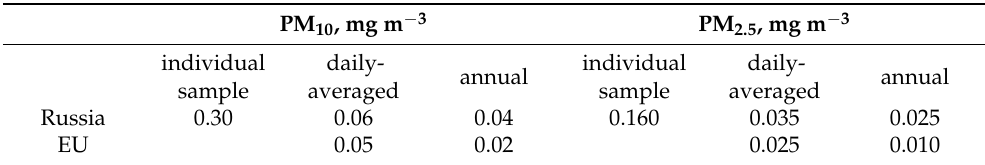
Table 2. MPC standards for the content of PM 2.5 and PM 10 in the atmosphere in the Russian Federation and in the EU